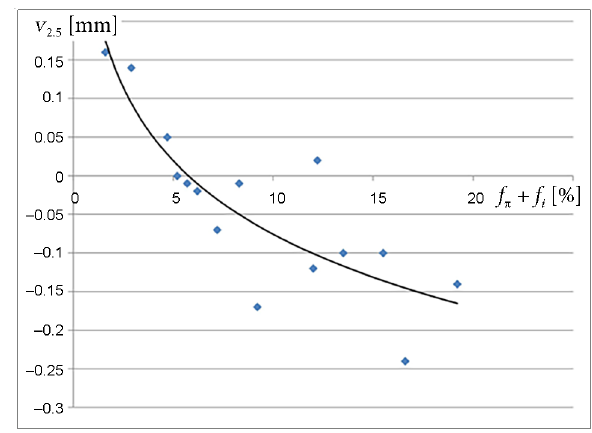
Figure 10. The dependence between annular surcharge rings displacement and the fine fraction content for penetration depth of 2.5 mm